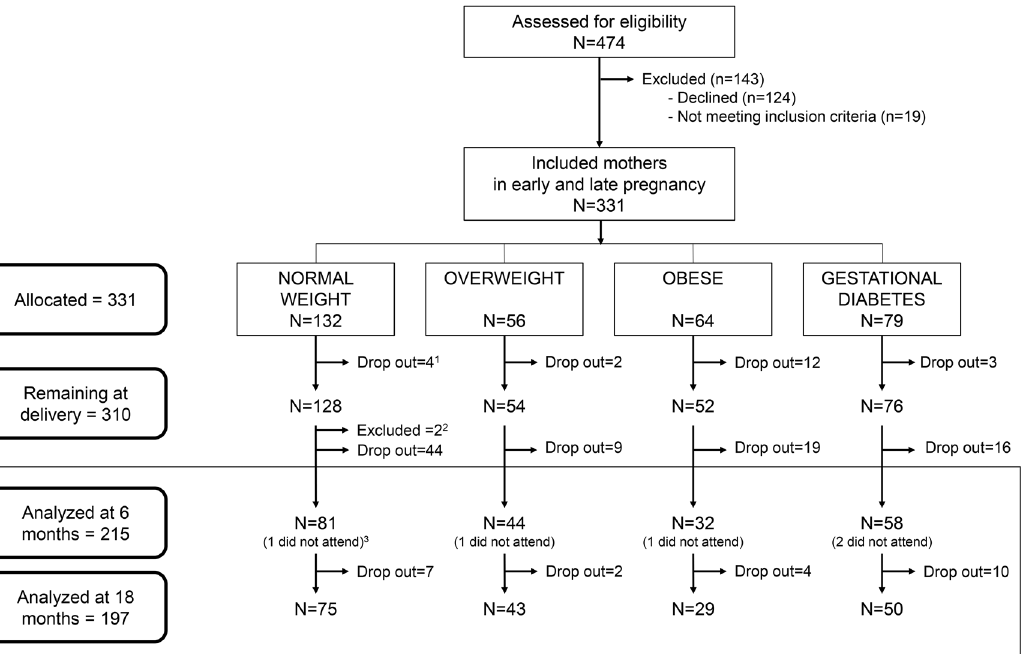
Fig 1. Trial profile of the neurodevelopmental follow-up. The study included 331 pregnant women at different stages of pregnancy but before 34 weeks of gestation. Included mothers were allocated to four different groups based on their pre-gestational BMI and their gestational diabetes status. 1 In total 21 mothers dropped out of the study before delivery without giving a reason. The 310 mother-child pairs who remained at delivery constituted the four PREOBE- groups in the present trial. 2 During early infancy, two children were excluded due to diagnosed congenital disorder (heart disease and immunodeficiency) and until 6 months, another 88 were lost to follow up giving no reason. 3 Five children did not attend to the 6 months Bayley test but came to the test at 18